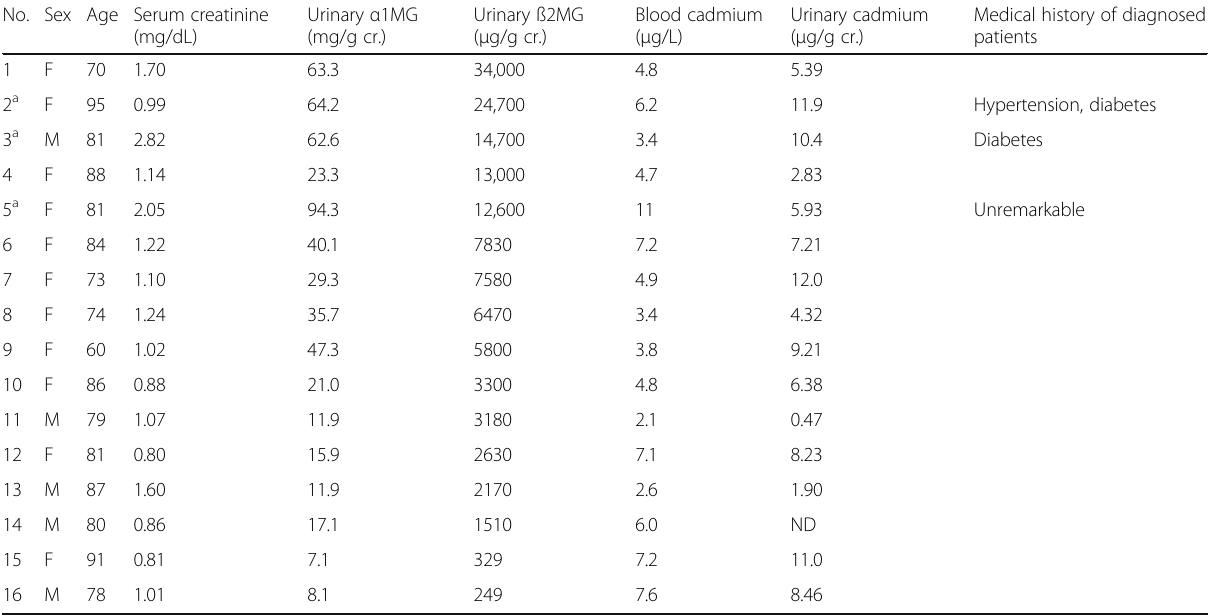
Table 2 Subjects who fulfilled at least one of three conditions: a urinary β 2 -microglobulin ( β 2MG) level higher than 1000 μ g/g cr., blood cadmium higher than 6 μ g/L, or urinary cadmium level higher than 10 μ g/g cr., out of 35 subjects in Akita Rosai Hospital in Odate city. The values of serum creatinine and urinary α 1 -microglobulin ( α 1MG) levels were also presented to support these data. They are listed in order of descending levels of urinary β 2MG